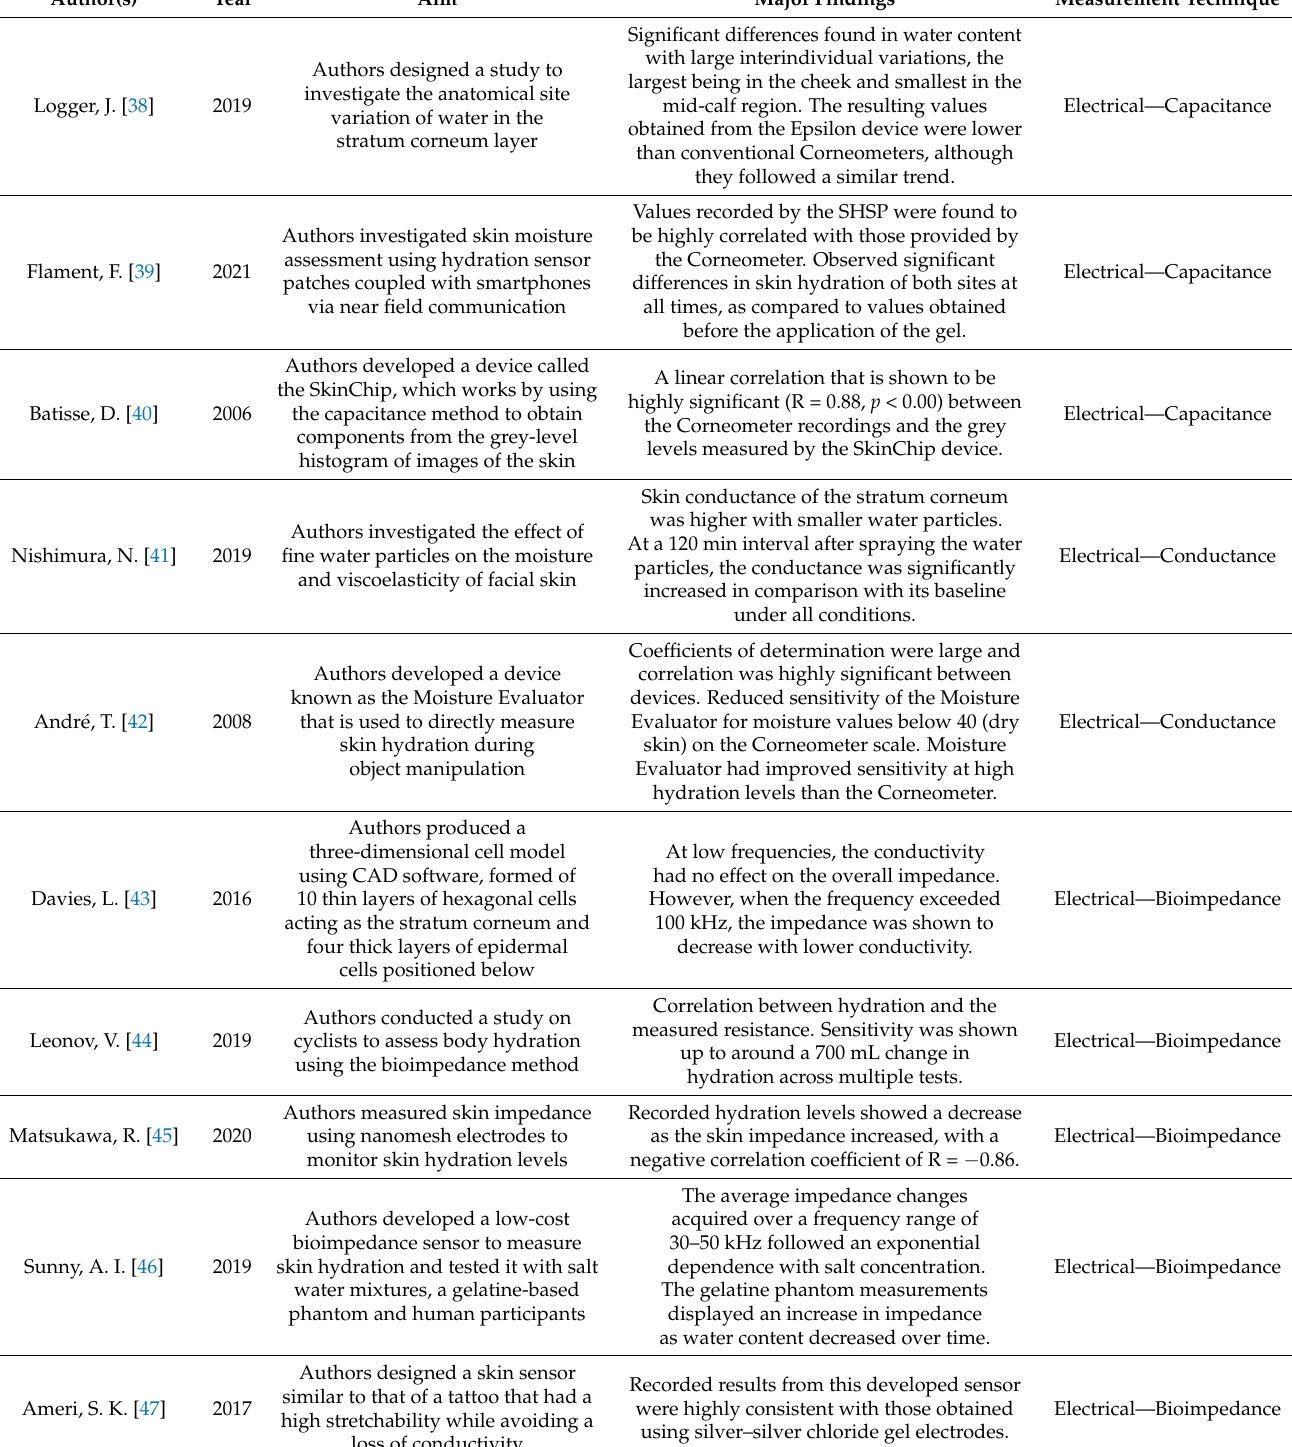
Table A2. Studies for the measurement of skin hydration using electrical-based